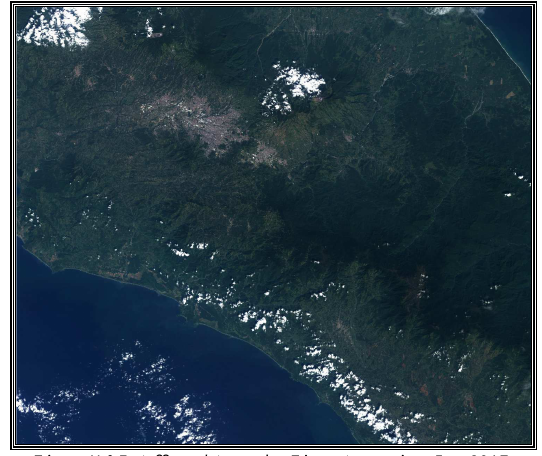
Figure N° 5: Affected Areas by Fire – Argentina, Jan, 2017, using VRSS.1 Image